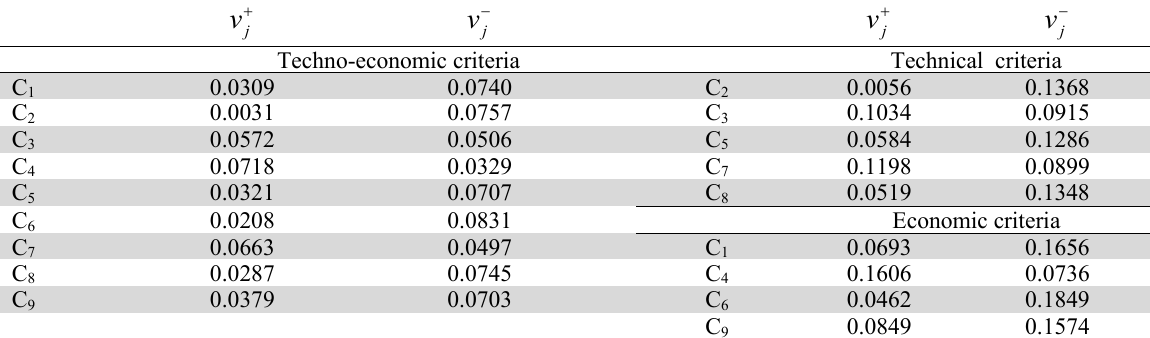
Positive and negative idea solutions for the evaluation process